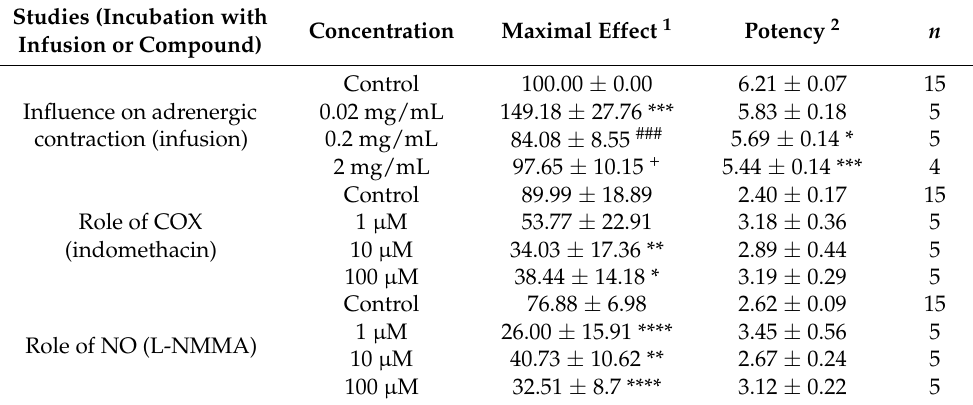
Table 2. Pharmacological parameters from vascular activity studies with A. eupatoria